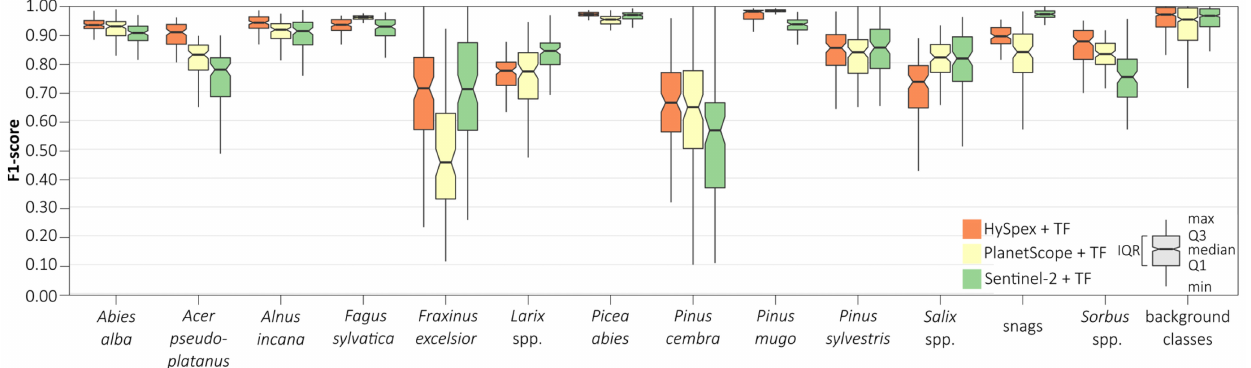
Figure 8. F1-score values for classes based on 100 iterations for 700 pixels using random forest as the classifier. IQR, interquartile range; Q1, lower quartile; Q3, upper quartile; TF, topographic features; (digital elevation model, canopy height model, and slope and aspect maps).